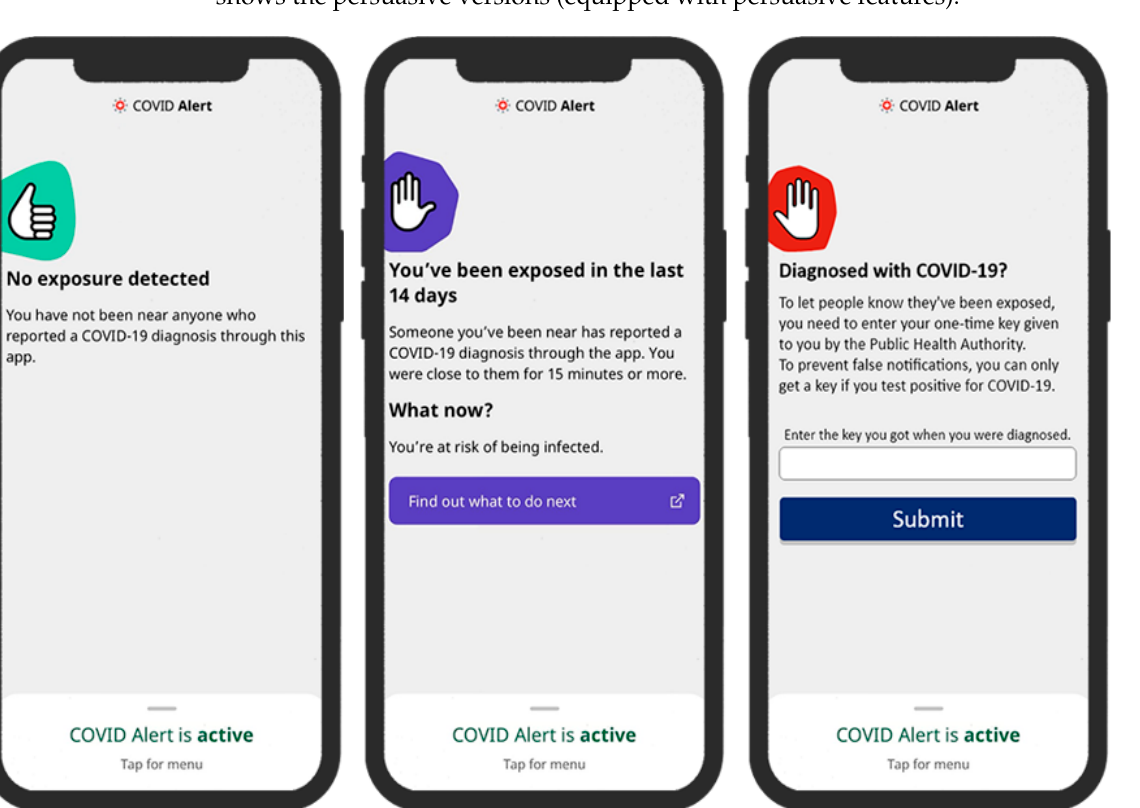
Figure 1. Persuasive versions showing the incorporation of self-monitoring (first, second) and social learning (third) [18].